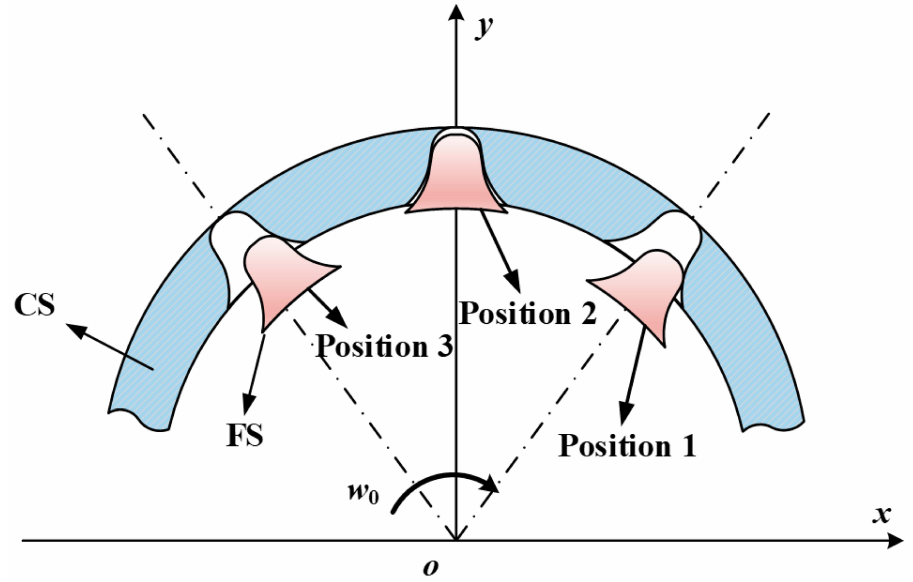
Figure 4. The engagement process. Based on the above equation, the wear depth after material removal is simulated by numerical method, and the wear numerical simulation flow is illustrated in Figure 5. First, the original parameters, including torque, pressure, and tooth profile, need to be input into the program. Wear is calculated based on the established mixed EHL model. To determine the wear depth at any position along the contact line, it is necessary to discretize the functioning tooth profile. A point on the tooth surface achieves threshold φ q after wear cycles during the process of gear wear. At this time, the slope angle of each discrete point continuously changes, as the tooth profile changes during the wear process. The slope angle obtained after each wear correction is used to correct other variables in the wear equation, such as pressure (p), sliding distance (s), contact area (A), sliding speed ( u s ), etc. Using this method, the wear-related variables are prevented from being constant or changing infrequently, and the time-varying nature and precision of the solution are significantly enhanced. Once